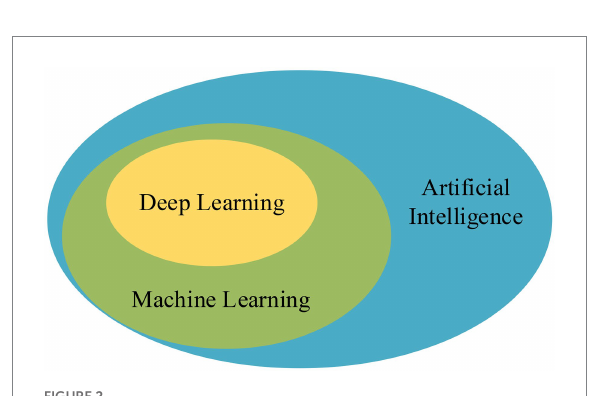
FIGURE 2 The relationship between AI, ML, and